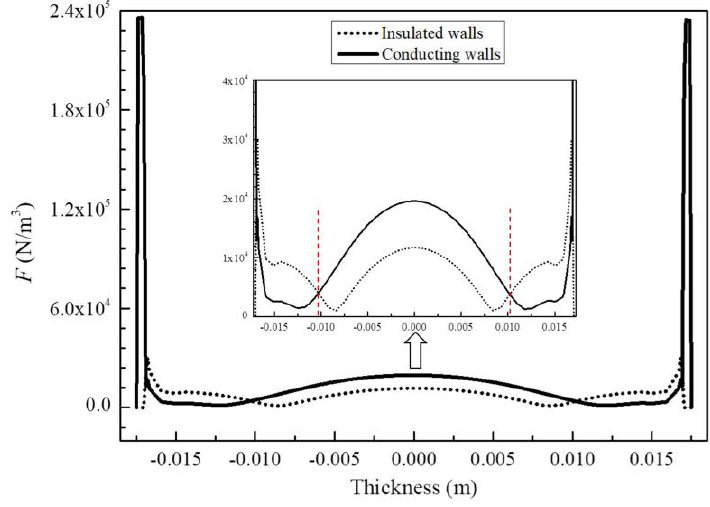
Figure 14. Time-averaged electromagnetic force distribution on line 4.